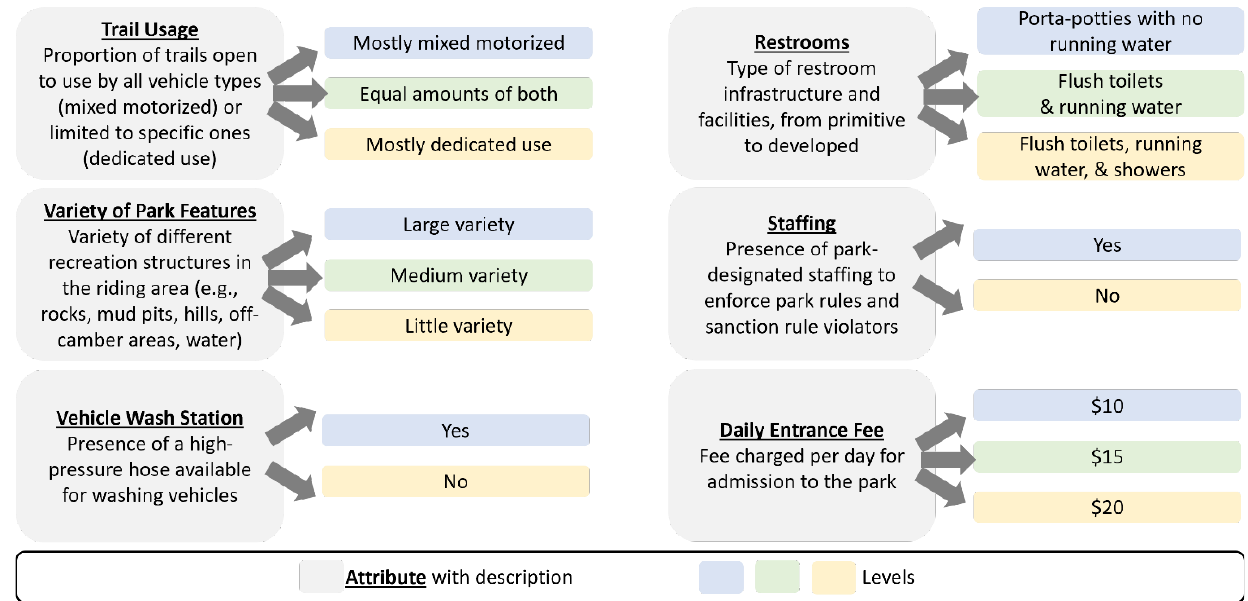
Figure 2. Attributes and levels used in the stated preference choice models.